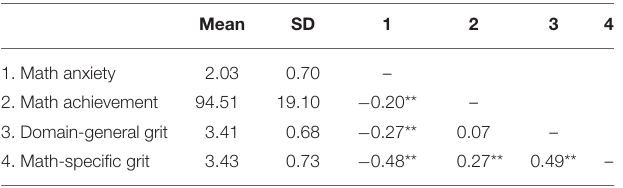
TABLE 1 | Means, standard deviations (SD), and correlations among the major variables in Study 1.